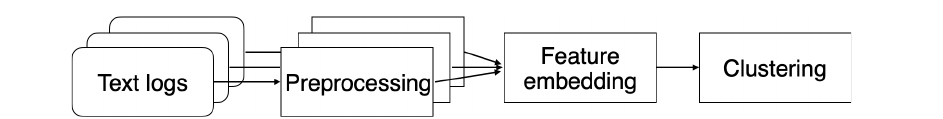
Figure 2: Components of the anomaly detection framework.